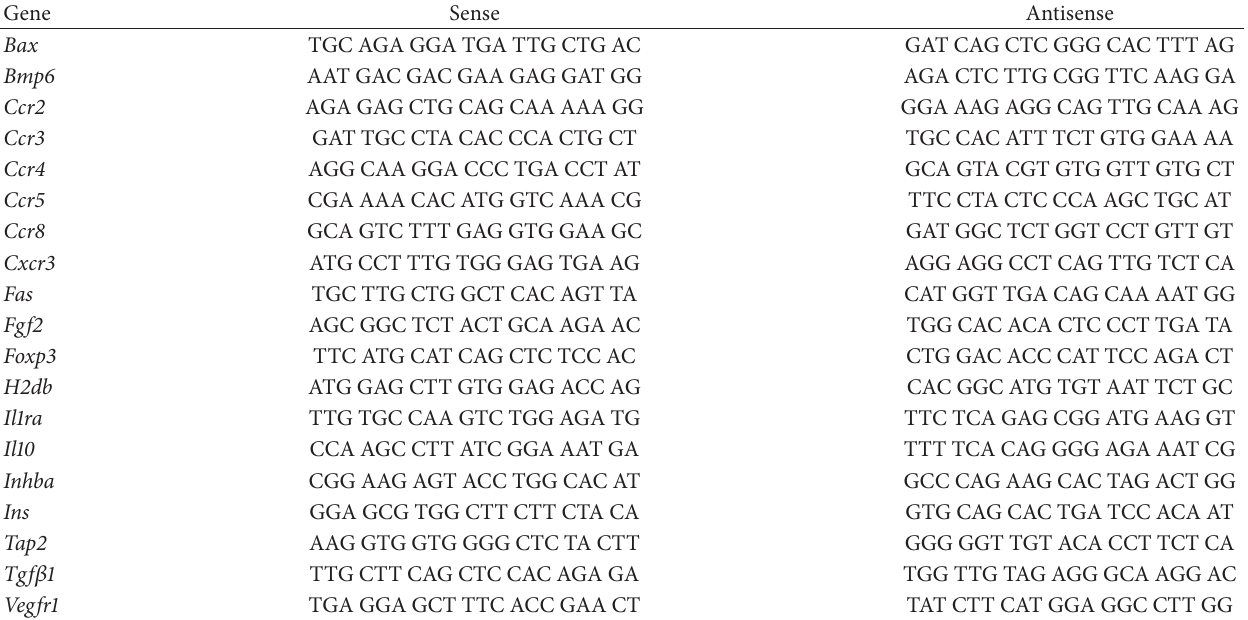
Table 1: PCR primer